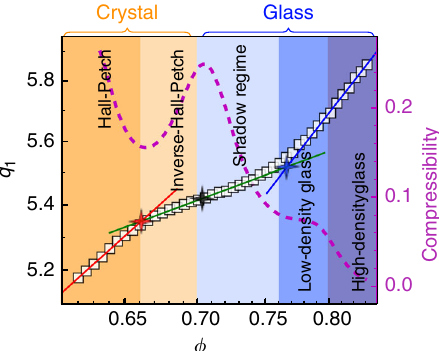
Fig. 2 Five regimes of the 2DSH system with ( η , λ ) = (0.5, 1.3). Their real- space structures are shown in Supplementary Fig. 1. Red, green and blue lines in the log – log plot denote the fi tted q 1 ∝ ϕ 1/ d in crystal, crossover and glass regimes, respectively. The intersection of the three lines coincide with the boundary between Hall – Petch and inverse-Hall – Petch behaviors (red star) and the boundary between the shadow glass and normal glass regimes (blue star) 16 . The slope of q 1 ( ϕ ) reaches the minimum at ϕ = 0.70 (black star), coinciding with the polycrystal-glass boundary identi fi ed in ref. 16 The fi ve regimes are identi fi ed in ref. 16 and can be roughly seen from the compressibility (dashed